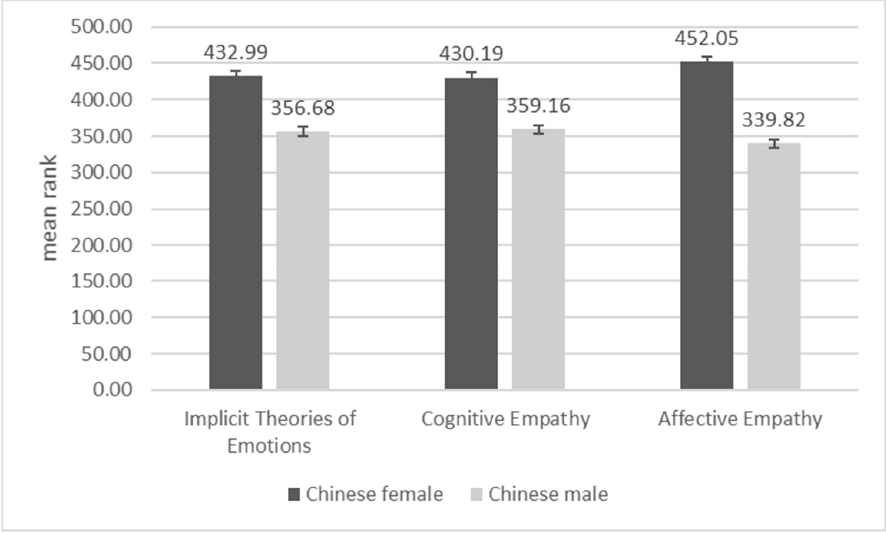
Figure 4. Differences between Chinese females and males on implicit theories of emotions, cognitive empathy, and affective empathy.